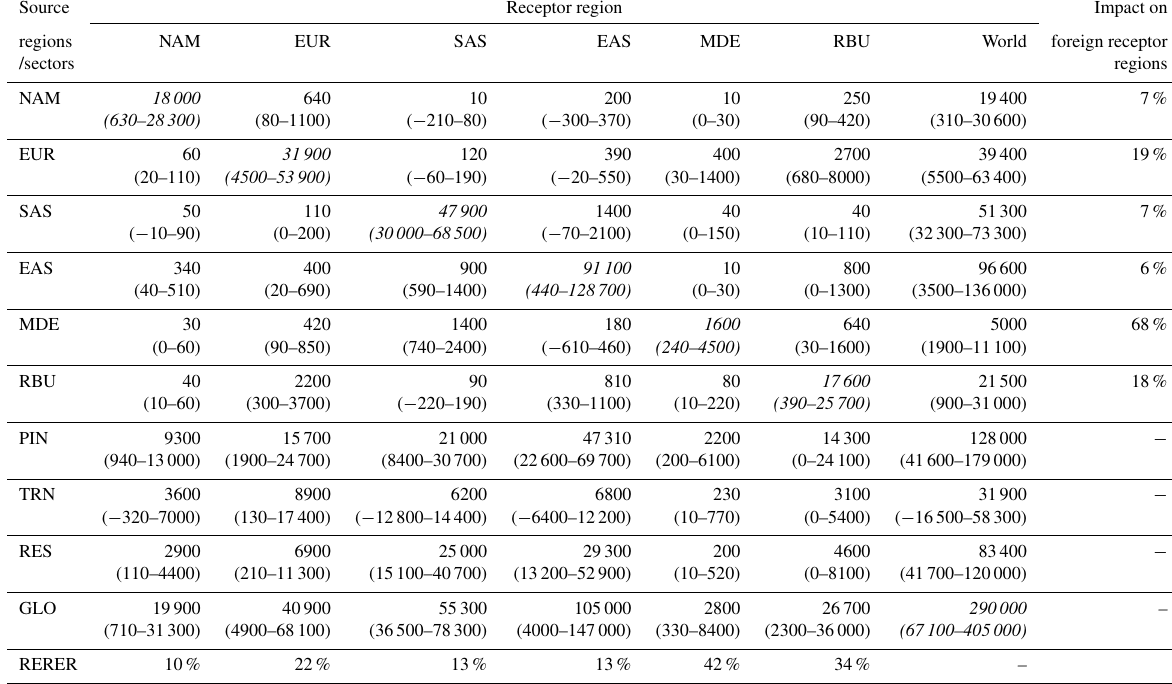
Table 6. Annual avoided multi-model empirical mean PM 2 . 5 -related premature deaths (IHD + STROKE + COPD + LC) with 95% CI from Monte Carlo simulations in parentheses due to 20% regional (NAM, EUR, SAS, MDE, and RBU), sectoral (PIN, TRN, and RES), and global (GLO) anthropogenic emission reductions in each region and worldwide. The diagonal, showing the effect of each region on itself, is shown in italics. For regional reductions, we also use the RERER (Eq. 4) as the percent of total avoided deaths in each receptor region that result from foreign emission reductions, as well as the percent of global avoided deaths from emission reductions in each source region. All numbers are rounded to three significant figures or the nearest 10 deaths.